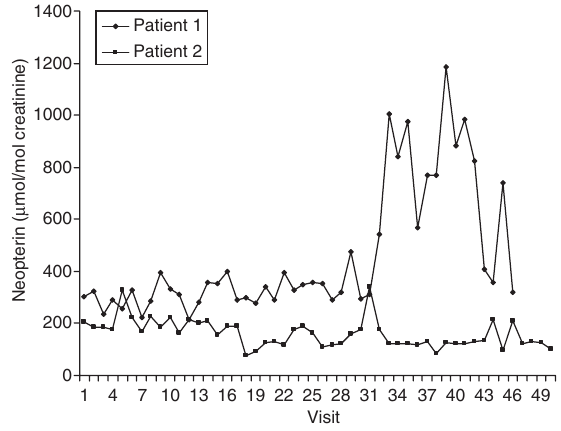
Figure 1 Urinary neopterin concentrations during the course of chemoradiation in patients 1 and 2. Patient 1, who had stage III.B cervical carcinoma and increased baseline urinary neopterin concentrations (301 μ mol/mol creatinine), started external beam radiotherapy on the day of visit 1 and the first administration of cisplatin on the day of visit 6. Uterovaginal brachytherapy was initiated on the day of visit 30 and continued for six fractions, with the last fraction administered on the day of visit 39. On the day of visit 37, the patient reported a burning sensation in the genital